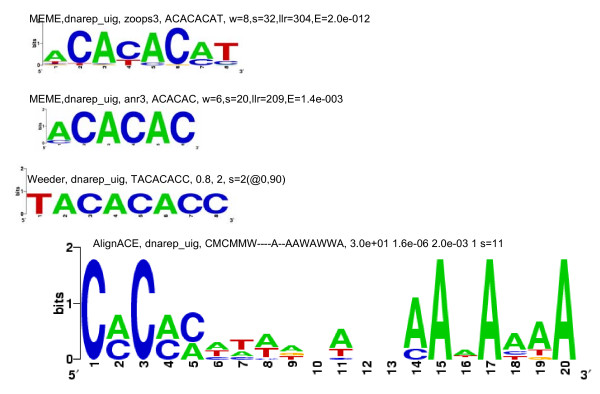
Sequence logos for CACA motif-sets identified in the upstream regions of the DNA replication machinery set of genes. Motif-sets are given in Additional file 2:12 and logo captions are explained in the legend to Figure 1.